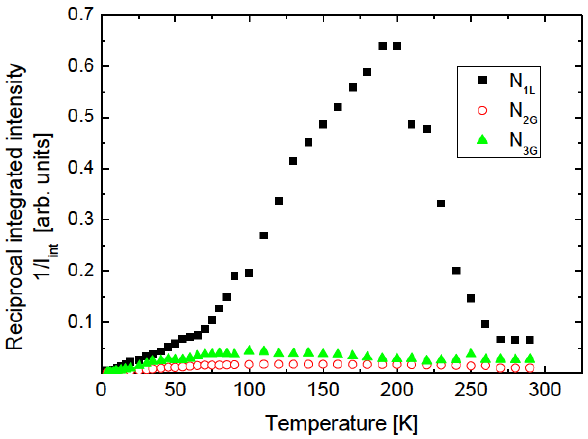
Figure 22: Temperature dependence of the reciprocal integrated intensity of the three subcomponents of the N component in B-400